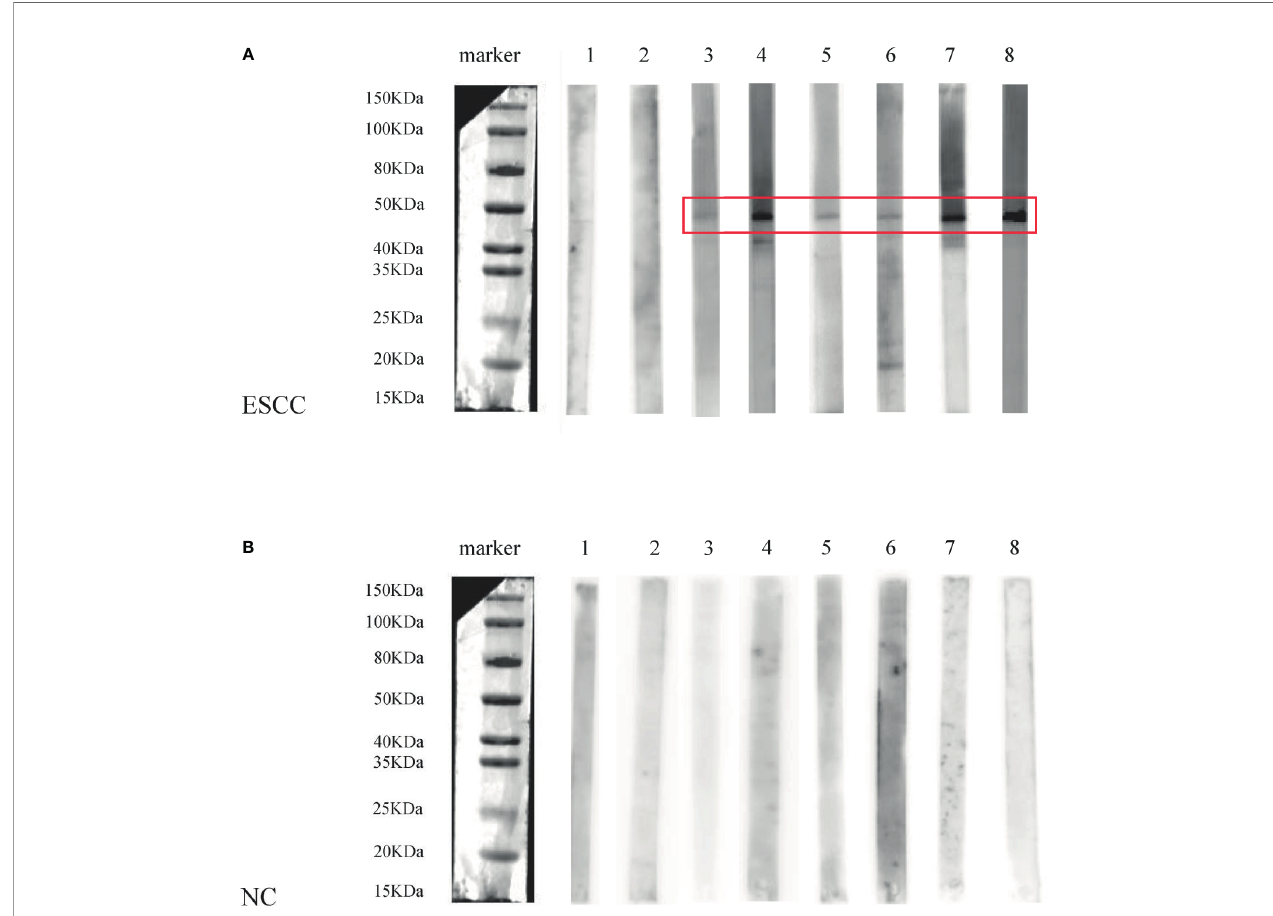
FIGURE 4 | The analysis of anti-GNA11 autoantibody by Western blotting in sera of eight ESCC patients and eight normal controls. ESCC, esophageal squamous cell carcinoma; NC, normal controls. (A) The results of Western blotting in sera of 8 ESCC patients, of which No. 1-2 was negative, and No. 3-8 showed a positive band near 45 kDa. (B) The results of Western blotting in 8 control sera were negative, and there was no positive band near 45